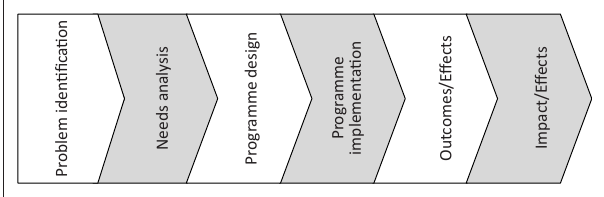
FIGURE 1: A framework of evaluation